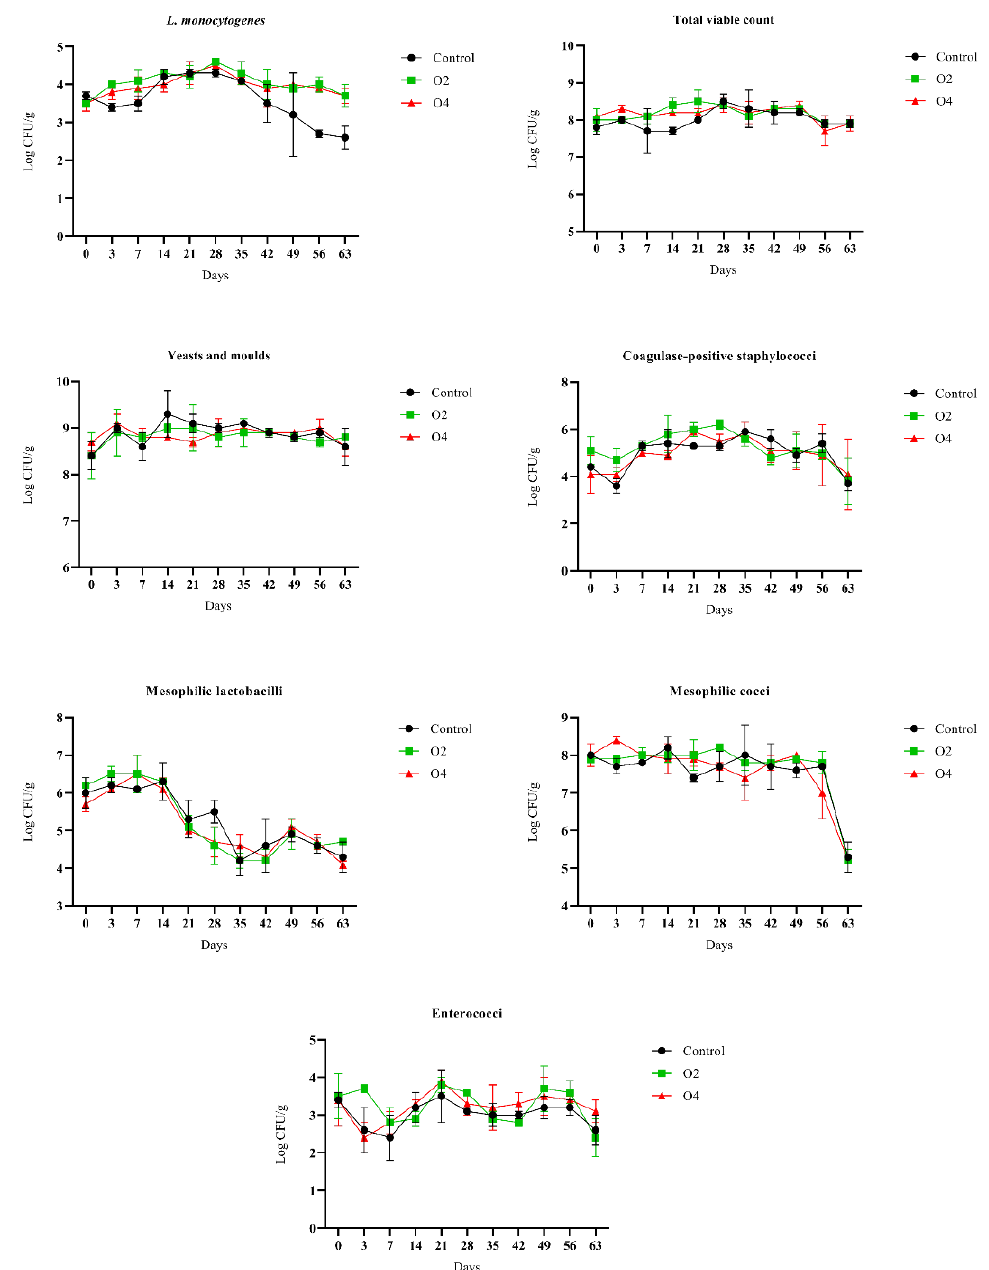
Figure 1. Behaviour of different microbial populations enumerated in control and ozone-treated (O2 and O4) rind samples during storage at 4 °C. Error bars indicate the standard deviation between three replicates.